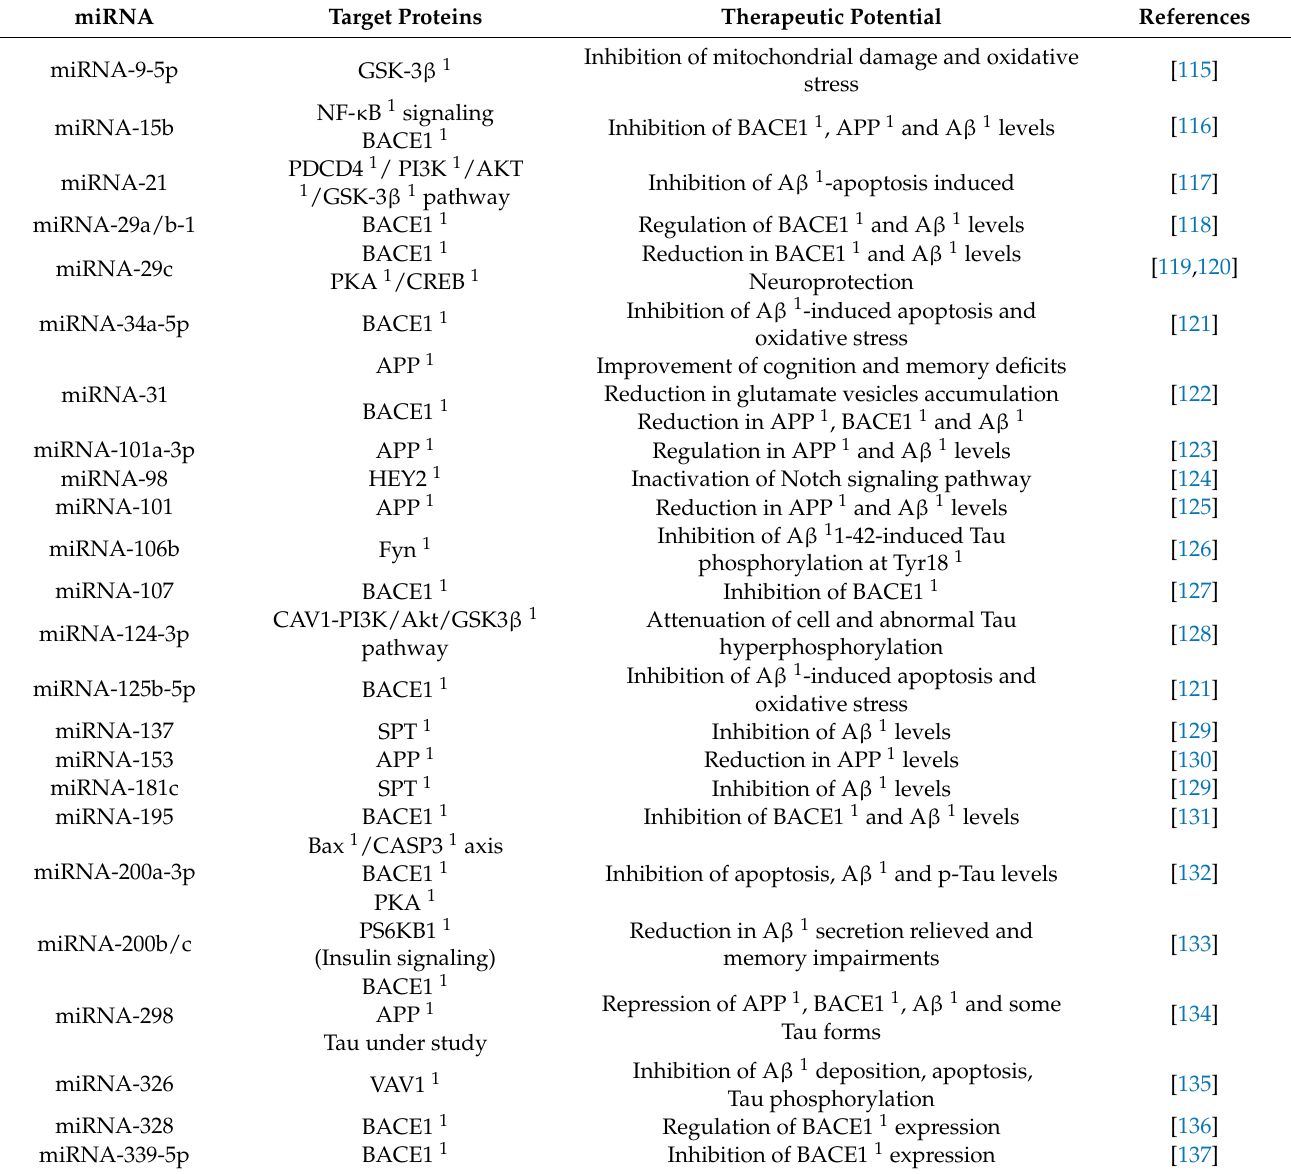
Table 4. Studies showing the therapeutic potential of miRNA in AD.